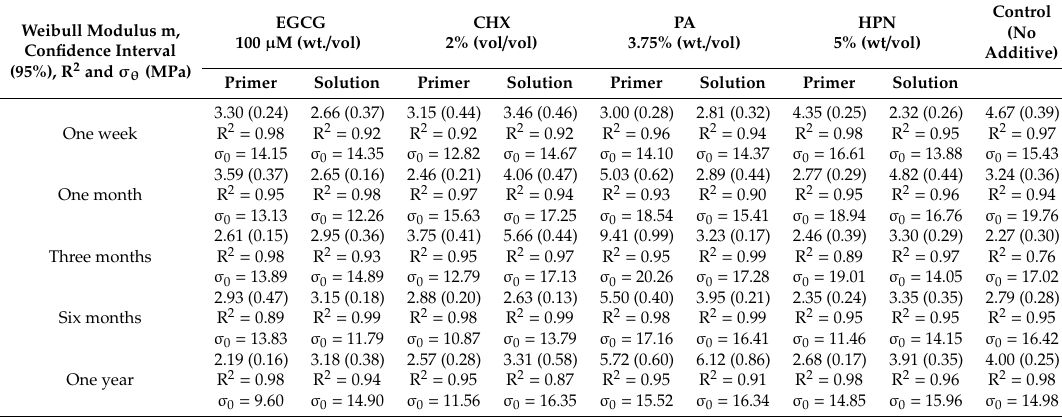
Table3. Weibullmodulusm, confidenceinterval(95%), coe ffi cientofdeterminationR 2, andcharacteristic strength σ 0 calculated for each test